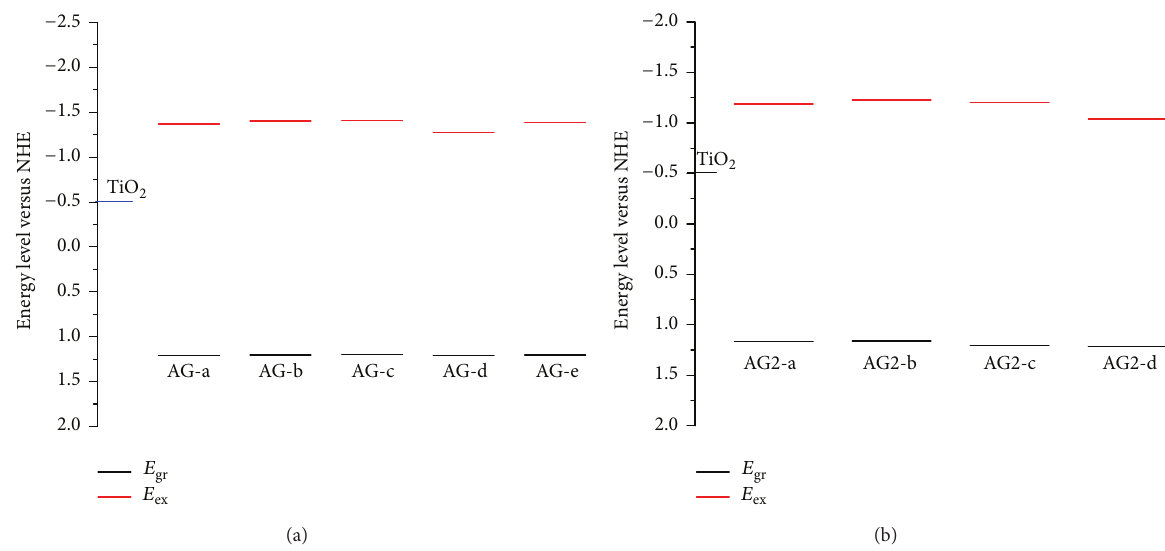
Figure 3: Energy levels of conduction bands of TiO 2 , ground state, and singlet excited states of designed dyes AG1-X (a) and AG2-X (b).